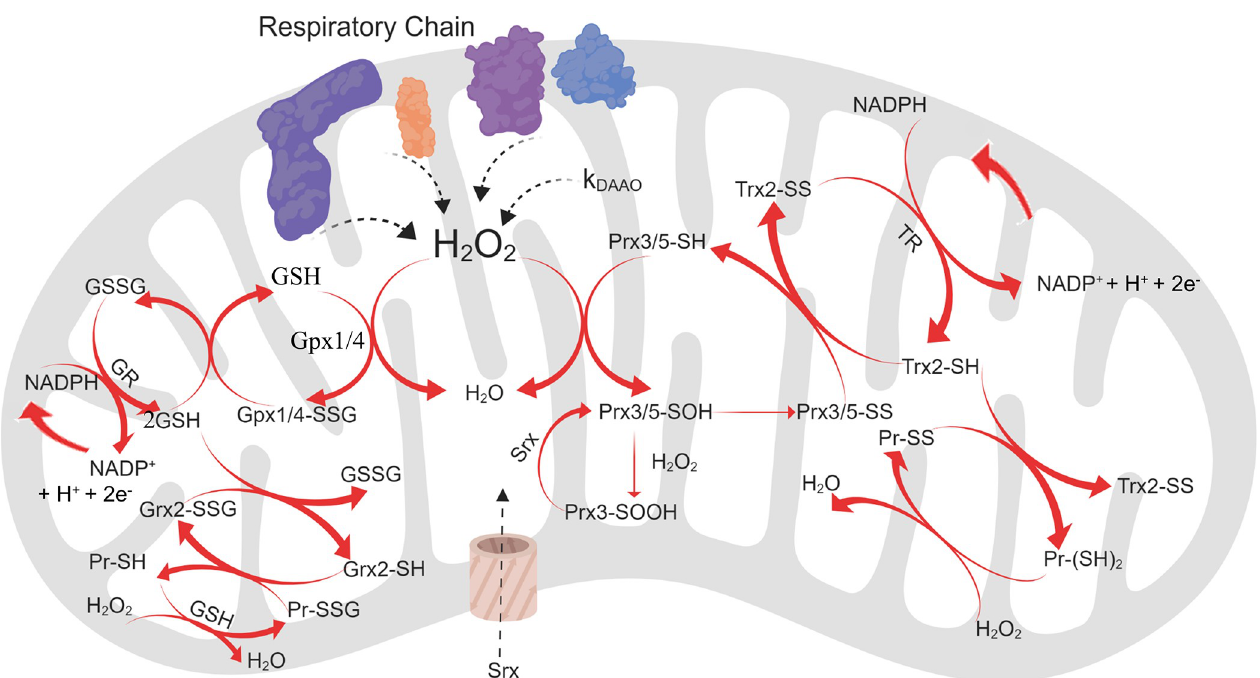
Fig 1. Schematic representation of the H 2 O 2 reaction network in the mitochondria. H 2 O 2 is evolved as a result of cellular respiration and the respiratory complexes at a rate that is taken as fixed for the purposes of this model. For the perturbation model only, H 2 O 2 is also added to the system by a variable source . It can then participate in reactions with the two Prx isoforms present in the mitochondria (Prx3 and Prx5), which are reduced by Trx2. H 2 O 2 can term, k DAAO also react with either of the Gpx isoforms in the mitochondria (Gpx1 and Gpx4), which involves reduction by GSH. Both of these networks require NADPH for reduction [36,37].Only Prx3 can undergo the hyperoxidation pathway, forming a sulfinic acid, which is reduced by Srx. Srx is imported into the mitochondria. Finally,